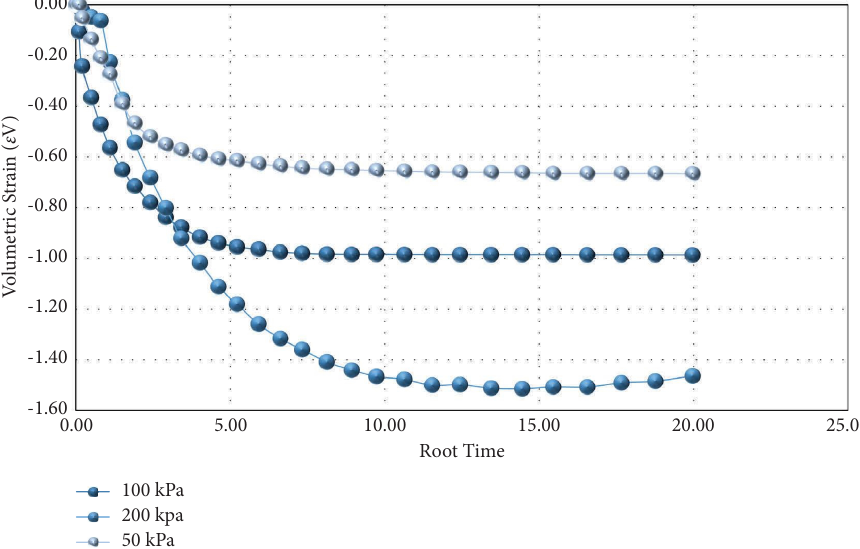
Figure 7: Volumetric changes in three efective confning pressures: CRHA-treated